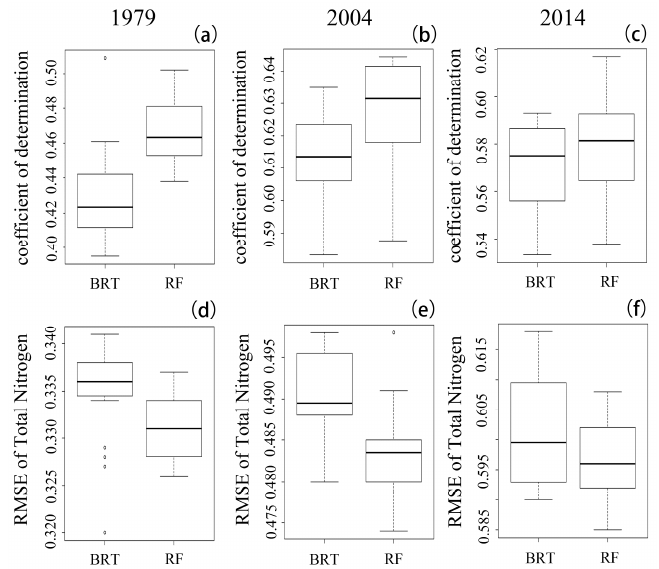
Figure 2. ( a – c ) Coefficients of determination from the 100 runs; ( d – f ) RMSEs from the 100 runs.